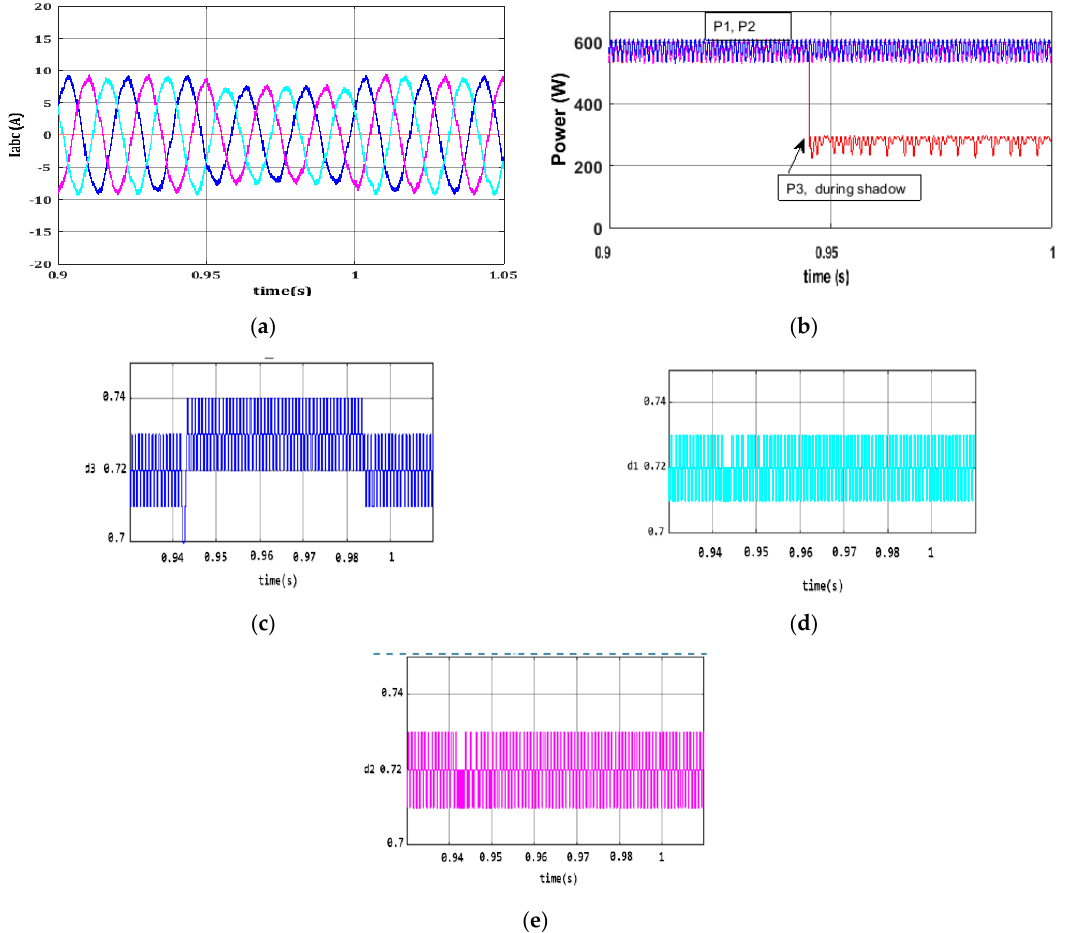
Figure 11. Simulation result of multi-input operation under partial shadow condition ( a ) the three-phase current, ( b ) the capacitor voltage V c , and the three input power values, ( c ) the duty cycle d 3 , for shadowed PV input, ( d ) the duty cycle d 2 , during the shadow condition, ( e ) the duty cycle d 1 , during the shadow condition.